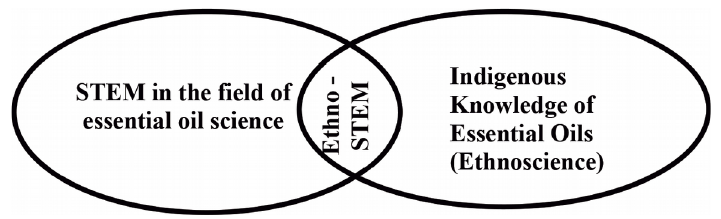
Figure 2. Ethno-STEM Approach Integrated Design Model for Essential Oil